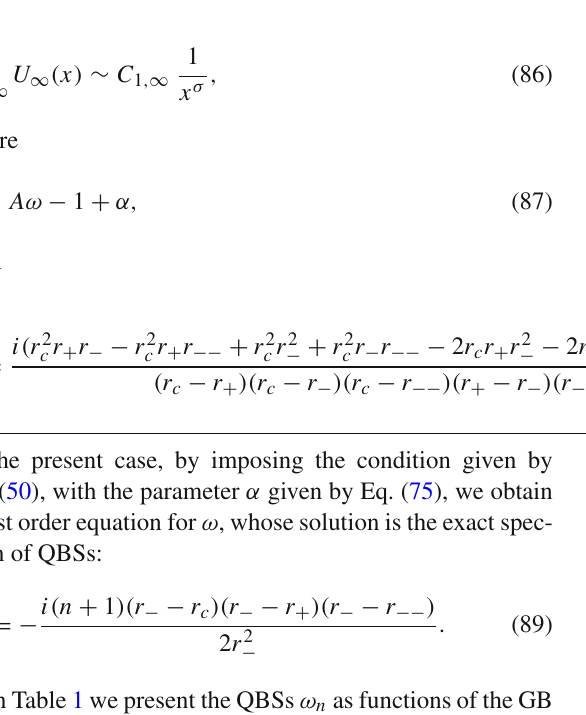
Fig. 5 (dS) Case 2: a > 0. Top panel: massless scalar QBSs as a function of the GB coupling constant for (cid:2) = 0 . 1 (left) and n = 0 (right); M = 1 / 2. Bottom panel: massless scalar QBSs as a function of the cosmological constant for a = 0 . 20 (left) and n = 0 (right); M = 1 /